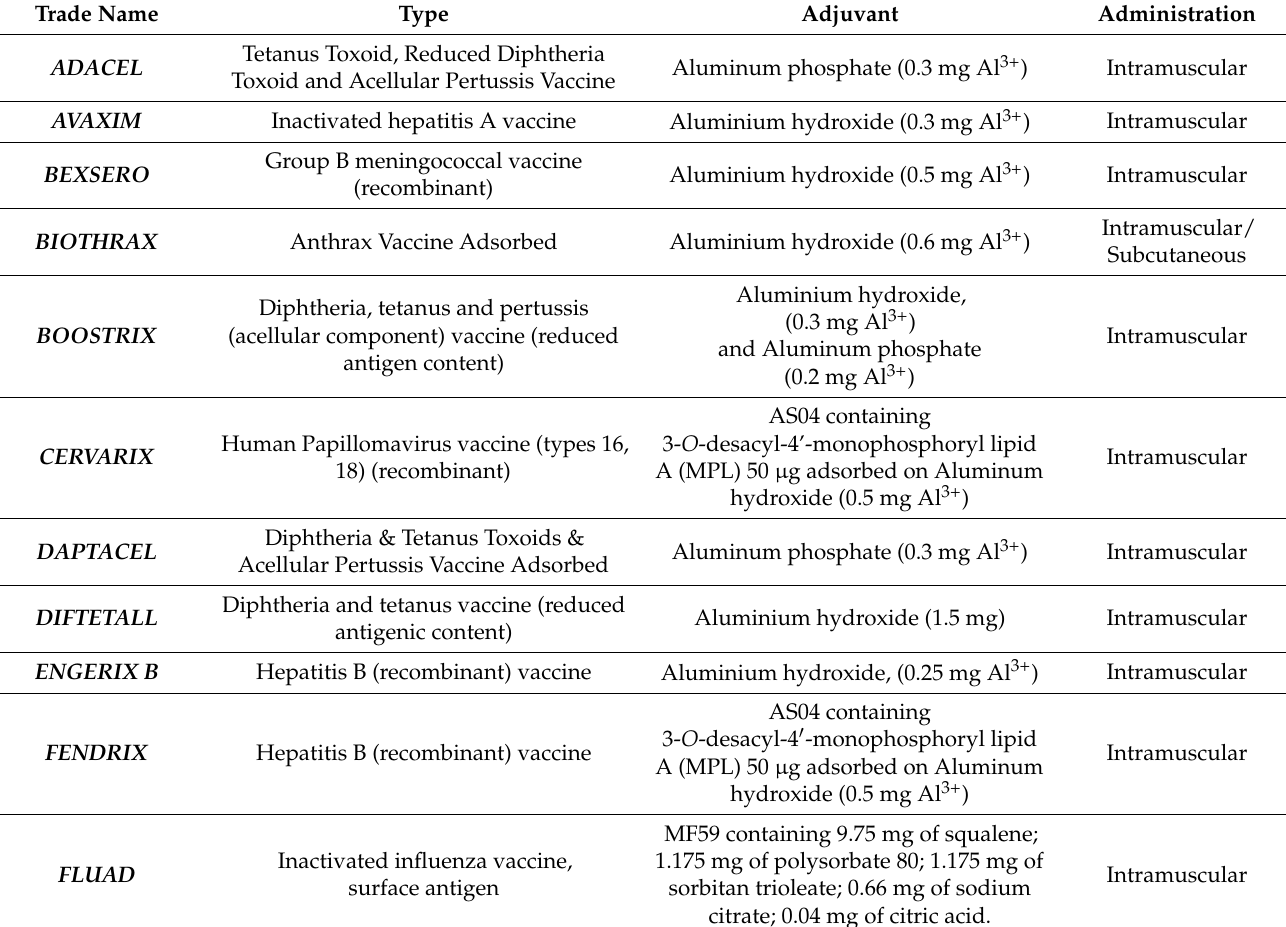
Table 2. Adjuvanted vaccines currently licensed by FDA and EMA for human use.